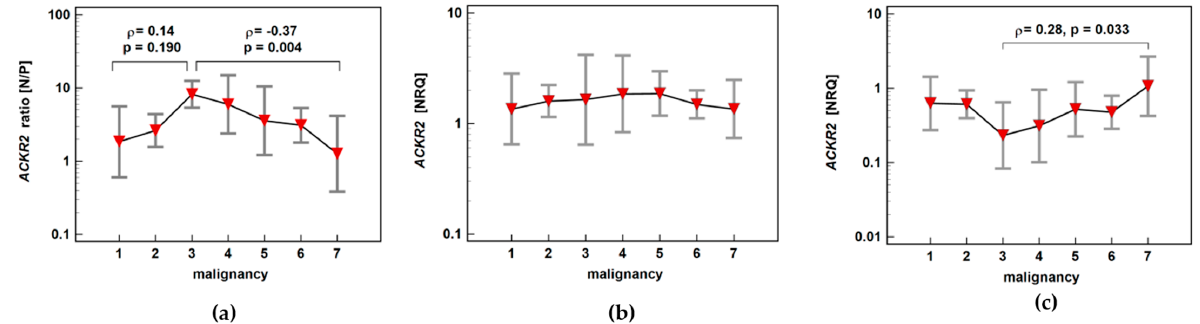
Figure 9. Impact of polyp risk for malignancy and cancer malignant potential on ( a ) ACKR2 expression ratio (normal-to- pathological) (N/P); ( b ) ACKR2 expression in normal mucosa; ( c ) ACKR2 expression in pathological tissue (adenoma or adenocarcinoma). Data presented as means with 95% confidence interval (red triangles with whiskers). The relationship was analyzed using Spearman rank correlation and expressed as correlation coefficient ρ . NRQ, normalized relative quantity.